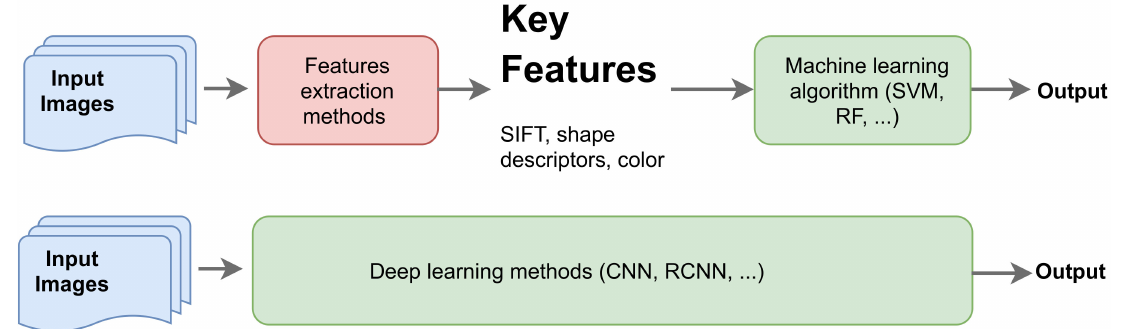
Figure 2. Traditional CV methods ( top ) vs. deep learning approach ( bottom